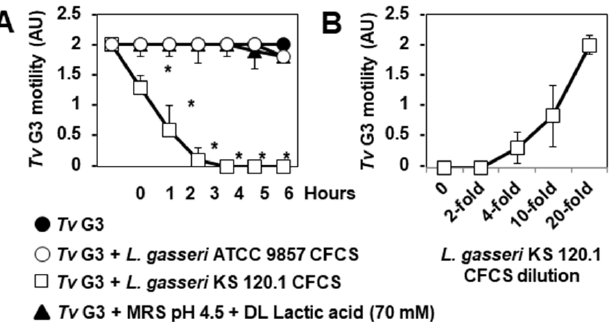
Figure 4. Strain-specific anti-trichomonadal activity of secreted L. gasseri KS 120.1 product(s). In ( A ), changes in the swimming motility of untreated and treated axenic trophozoites over the period of direct contact. In ( B ), concentration-dependent inhibition of parasite swimming motility. CFCS: cell-free culture supernatant. Each value shown is the mean ± SD of two experiments. In ( A ), * p < 0.01 for comparisons with Tv G3.